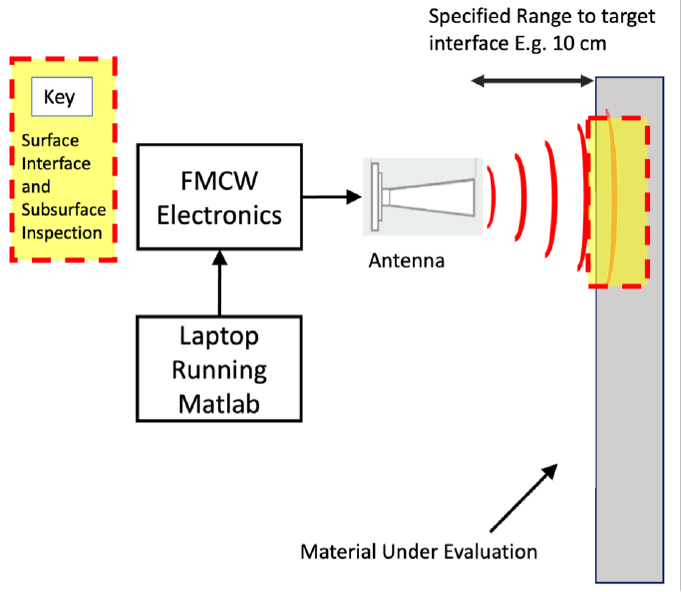
Figure 2. FMCW Radar setup for procedures